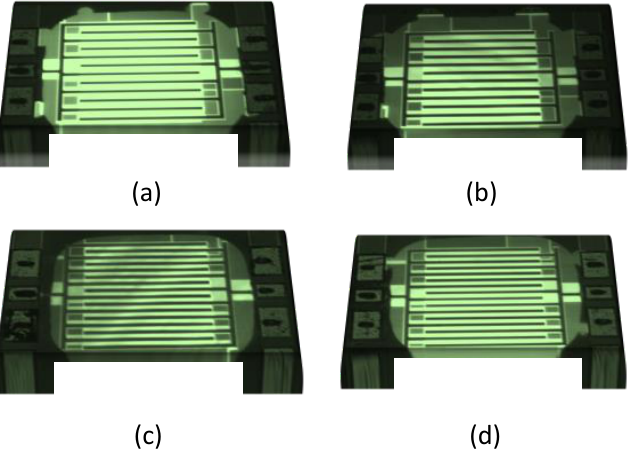
Table 1. Dimensions of the studied capacitive coupling structures.